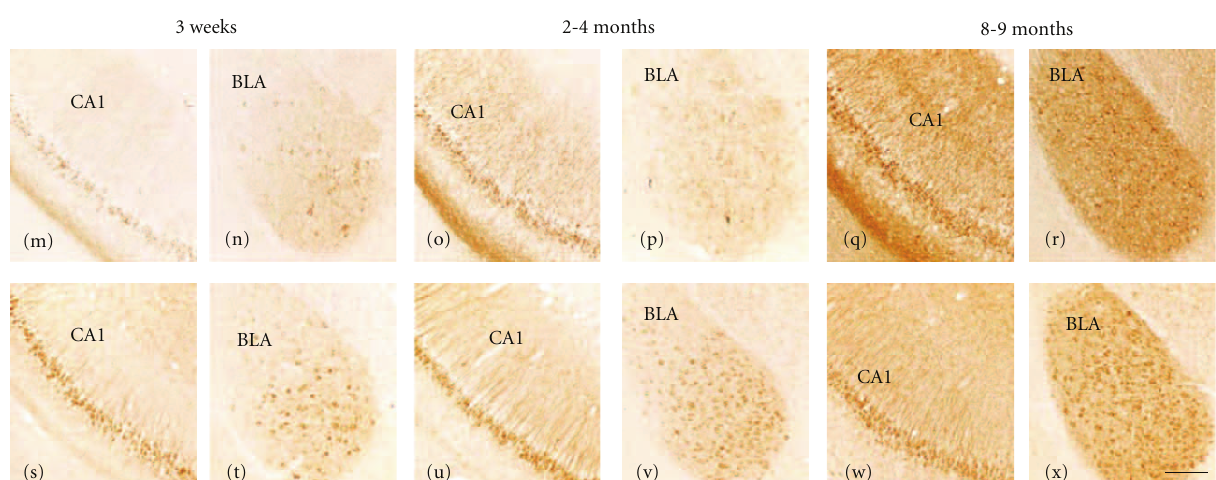
Figure 1: Photomicrographs of 6E10, AT8, PHF-1, Alz50, and AT180 intraneuronal and neuropil immunostaining in the CA1 field of the hippocampus and basolateral nucleus of the amygdala (BLA) at 3 weeks, 2–4-, and 8-9-month-old male 3xTg-AD mice. Note the di ff erences in immunoreactivity between immersion and perfusion-fixed tissue in 3-week-old 3xTg-AD mice for 6E10 ((a)–(d)), AT8 ((e)– (h)), and PHF-1 ((i)–(l)). Alz50 ((m)–(r)) and AT180 ((s)–(x)) immunoreactivity was increased with age-dependent increases in the ventral hippocampus, ((m), (o), (q), and (s), (u), (w)) and basolateral amygdala, ((n), (p), (r) and (t), (v), (x)). Abbreviation: DG: dentate gyrus. Scale bar = 100 μ